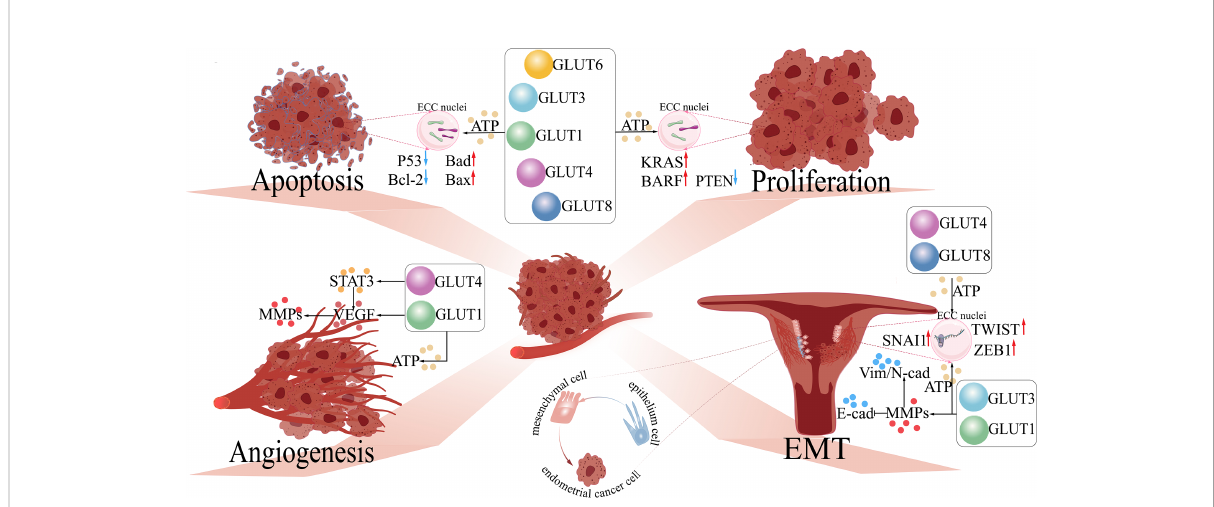
FIGURE 1 The functions of GLUTs in endometrial cancer. 1) Proliferation: GLUTs upregulate the expression of oncogenes (e.g., KRAS and BARF) and inhibit anti-oncogenes (e.g., PTEN) in endometrial cancer cells (ECCs) by providing abundant ATP for cellular metabolism. 2) Apoptosis: GLUTs downregulate pro-apoptosis genes (e.g., P53 and Bcl-2) and upregulate anti-apoptosis genes (e.g., Bad and Bax) in ECCs. 3) Angiogenesis: GLUT1 regulates VEGF and its downstream molecule (MMPs), further accelerating angiogenesis in ECCs by activating STAT3. 4) EMT: GLUT1/3 regulates the expression of EMT-related proteins (Vim, N-cad, and E-cad) by upregulating the levels of MMPs in ECCs, facilitating the development of EMT in ECCs; GLUT4/8 activates EMT-related transcription factors (TWIST, SNAI1, ZEB1) of ECCs. GLUTs, glucose transporters; STAT3, signal transducer and activator of transcription 3; VEGF, vascular and epidermal growth factor; MMPs, matrix metalloproteinases; EMT, epithelial – mesenchymal transition; Bcl-2, B-cell lymphoma-2; Bad, Bcl-2 agonist of cell death; Bax, BCL2-associated X; KRAS, Kirsten rat sarcoma; BARF: Bam HI A right frame 1; PTEN, phosphatase and tensin homolog; TWIST, time without signi fi cant symptoms of toxicity protein; SNAI, Snail-1 protein.